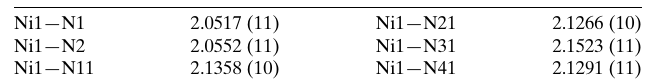
Table 3 Selected bond lengths (A˚ ) for 3 .